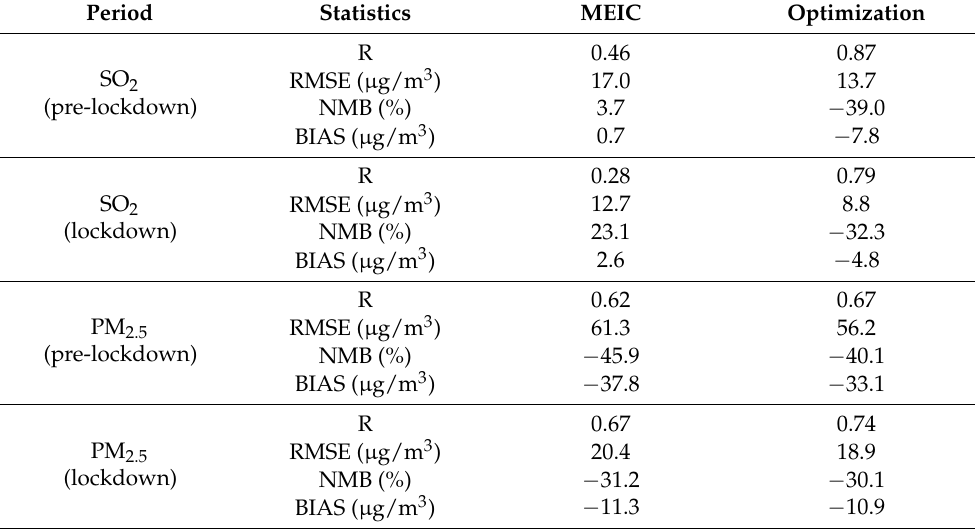
Table 2. The statistics of model simulation and observation data of SO 2 and PM 2.5 concentrations for MEIC and optimized inventories during the lockdown and pre-lockdown